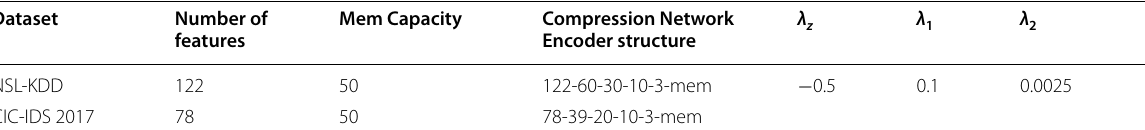
Table 3 Encoder structure configuration